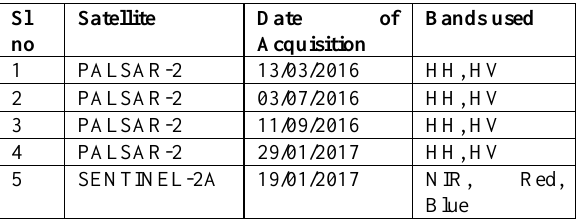
Table 1. Metadata of Datasets